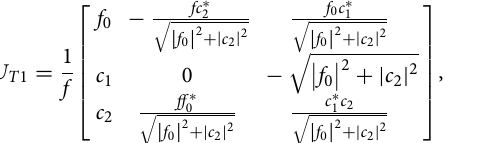
Figure 4. Quantum circuit for a qubit-qutrit hybrid system. The system is initialized to qubit e can be prepared in an arbitrary state UE-parameters, and then three controlled operators generate the three UE terms, where the first dashed C 0 σ 0 is not essential in practice. Next, another single-qutrit rotation superposes the three UE terms. Finally, a − measurement is performed on the ancillary qudit to simulate the nonunitary F ( t )